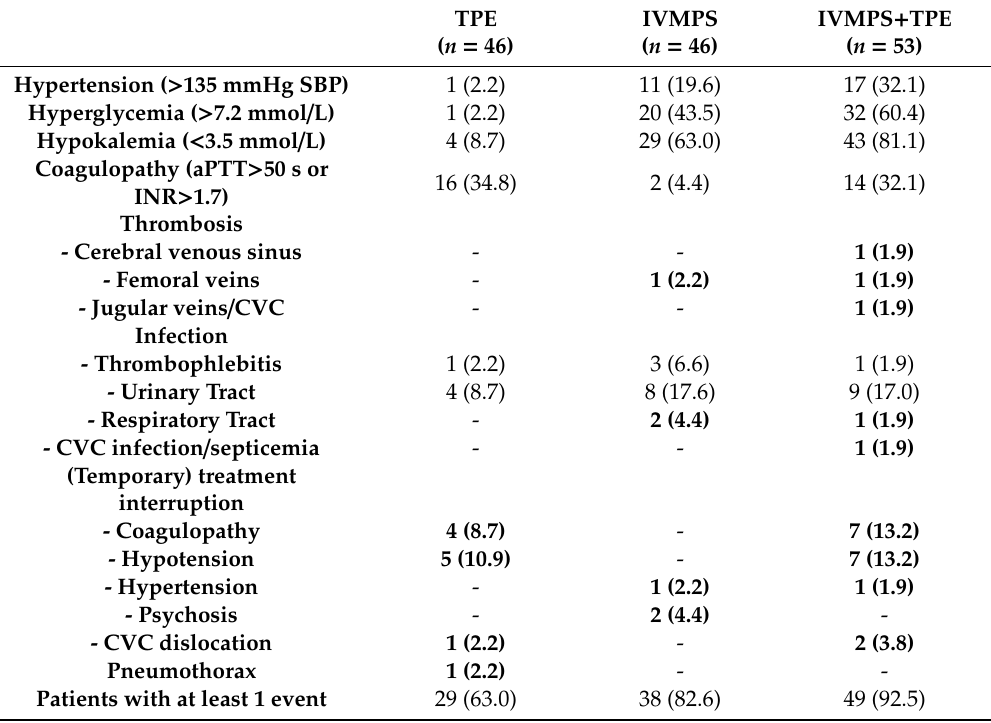
Table 2. Overview of documented adverse events during